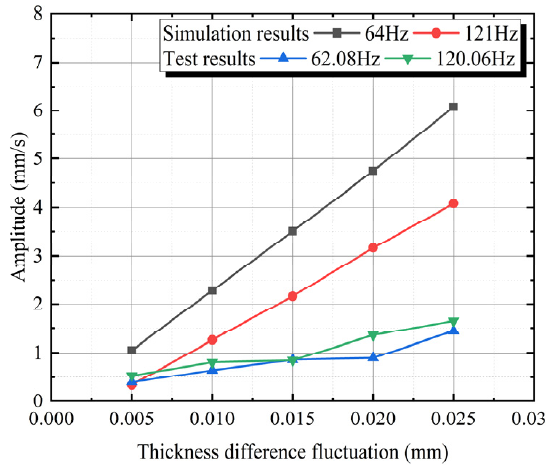
Figure 13. Plate thickness affects torsional vibration .